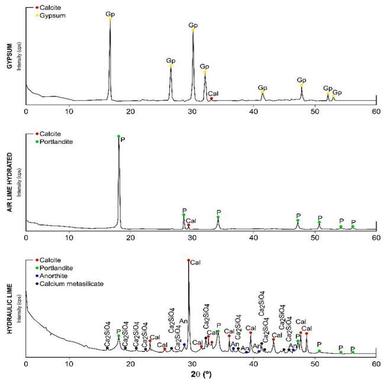
XRD diffractogram of the gypsum, hydraulic lime and air lime.